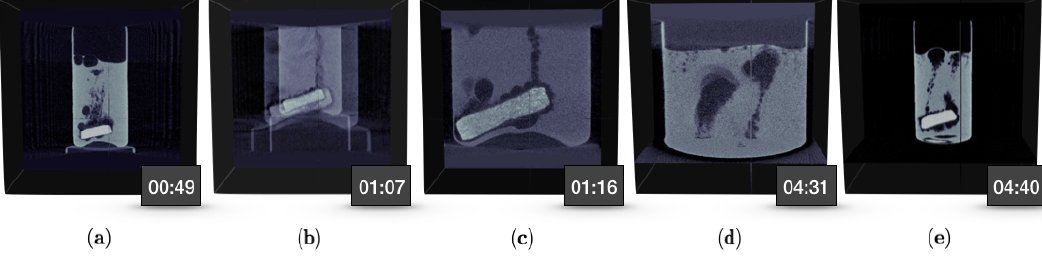
Figure 16. A series of frames from the live reconstructions, showing the initial magnification capturing the whole sample ( a ); the effect of zooming in during live reconstruction ( b ); reconstructions at higher magnification of the bottom part of the sample after the zoom ( c ); reconstructions at higher magnification of the top part of the sample after the shift in vertical axis ( d ); and zooming back out to the original magnification ( e